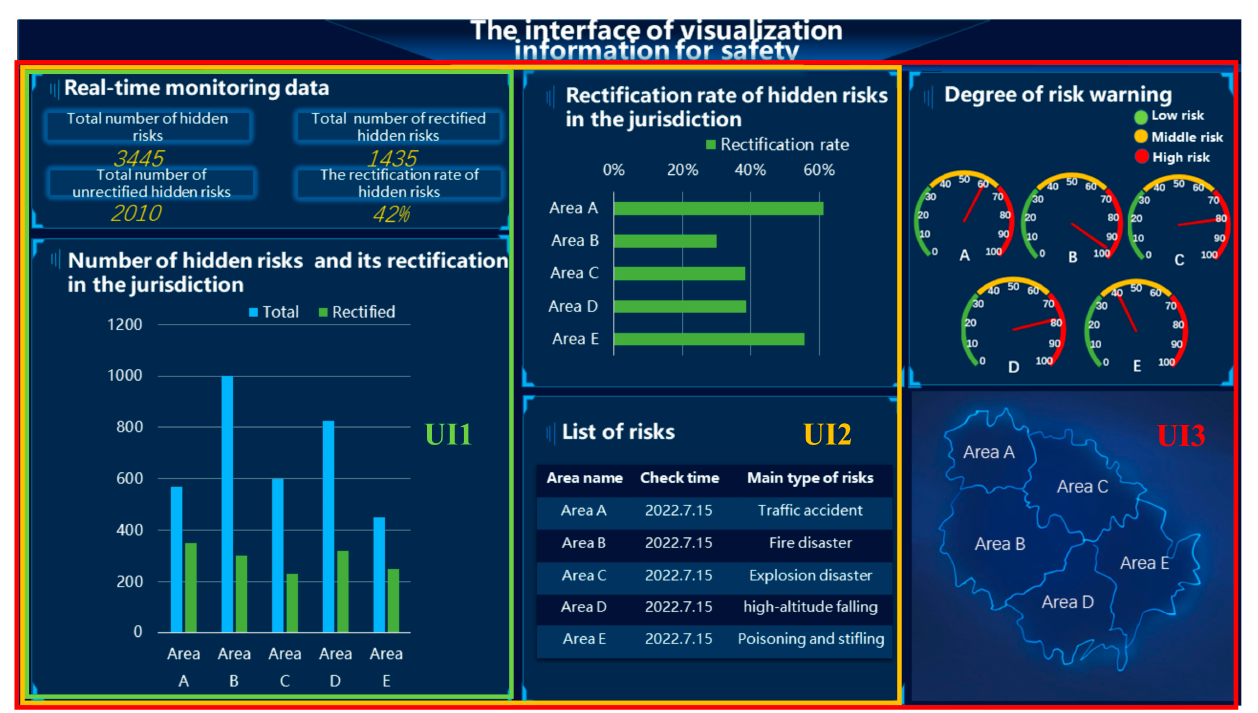
Figure 2. Three-level UI design for VIS presentation (English version). Note. This figure shows the UIs employed in the study. The green-line box is the level-1 UI, the orange-line box is the level-2 UI, and the red-line box is the level-3 UI.